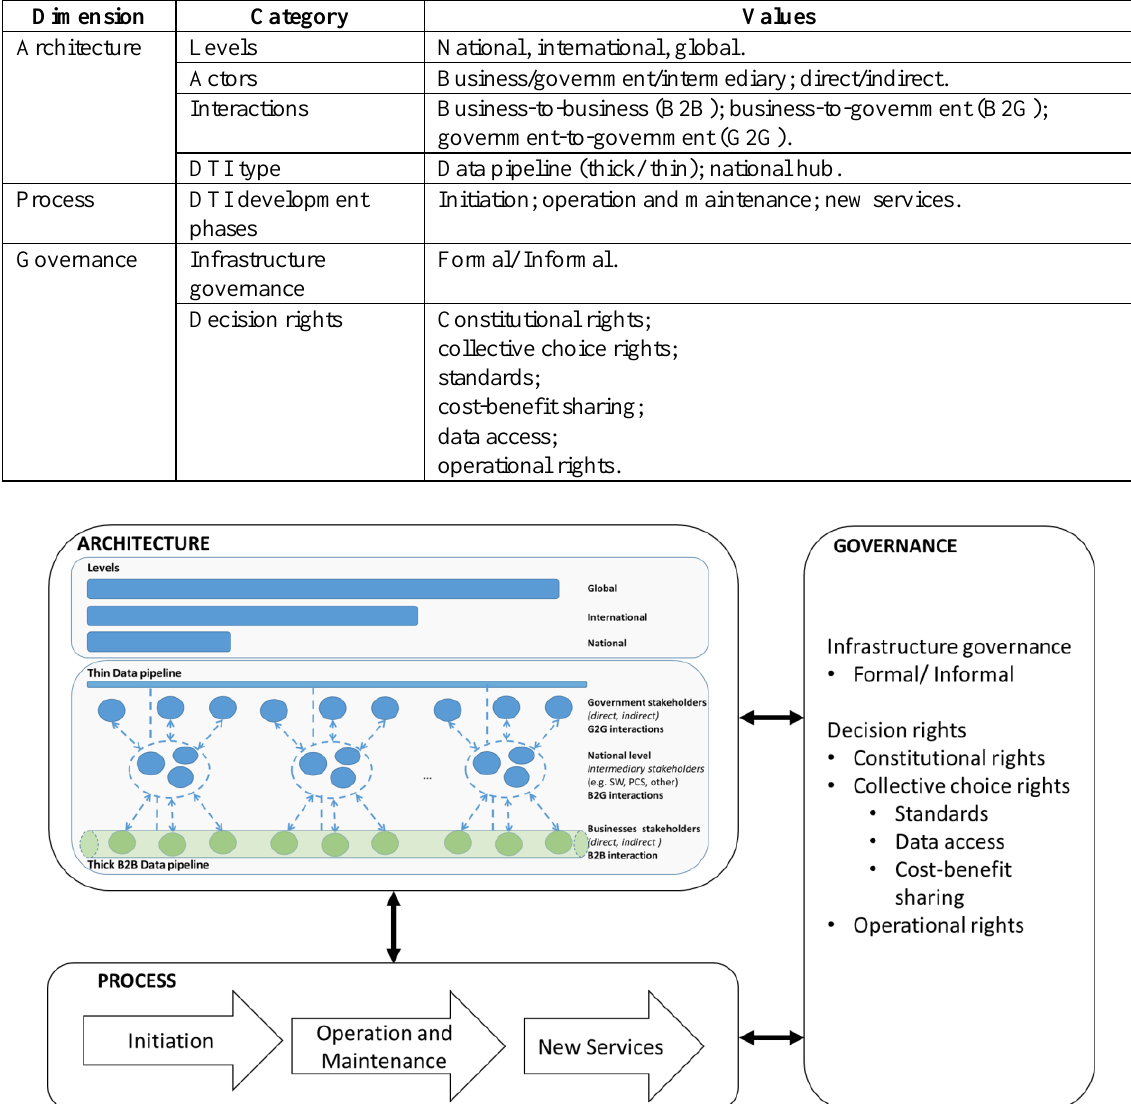
Table 2. The DTI framework